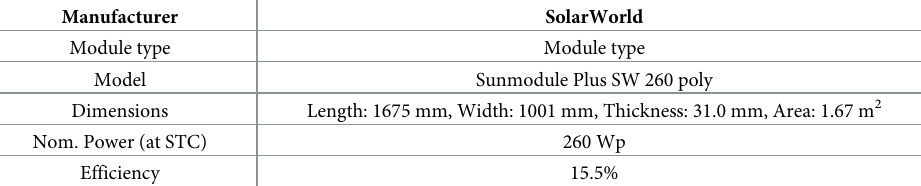
Table 3. Characterization of reference module